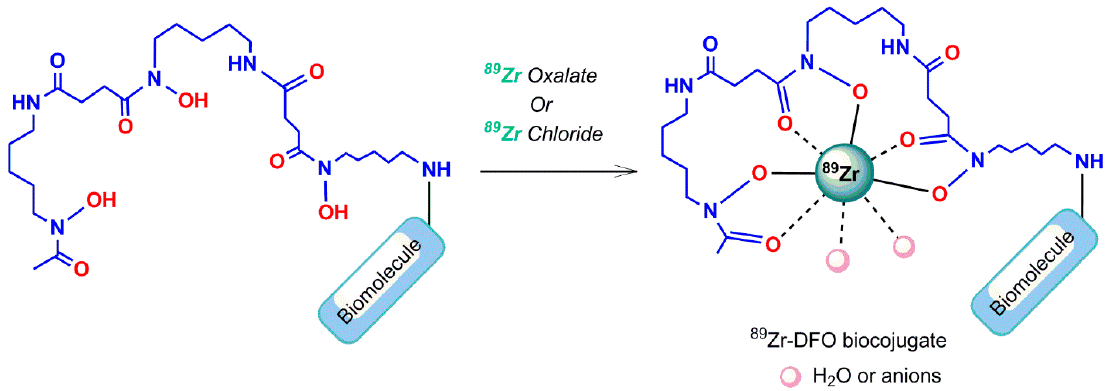
Figure 17. Conjugation of 89 Zr to a Desferrioxamine B (DFO) bioconjugate.